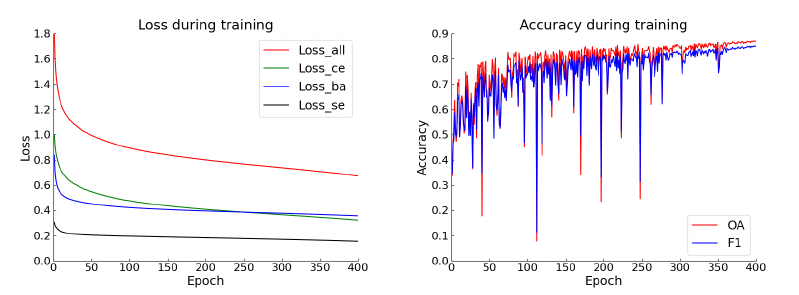
Figure 8. Loss and accuracy during the training